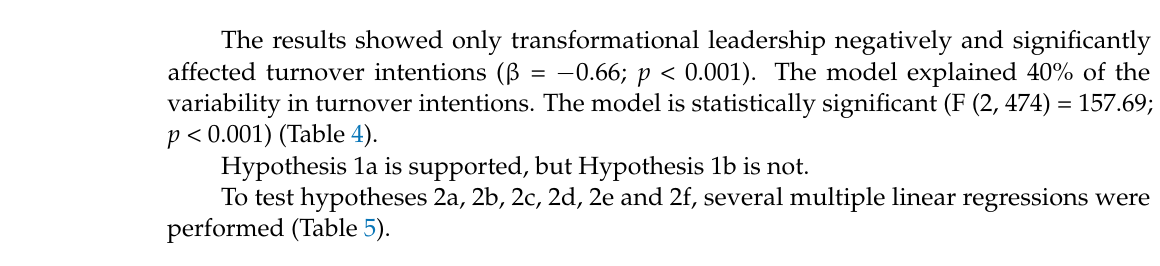
Table 5. Leadership and Organisational Commitment (H2a, H2b, H2c, H2d, H2e and